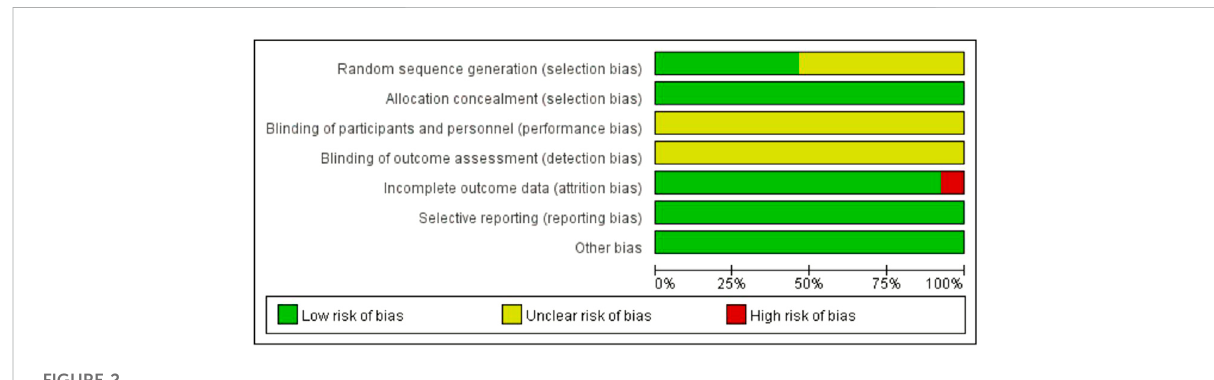
FIGURE 2 Risk of bias